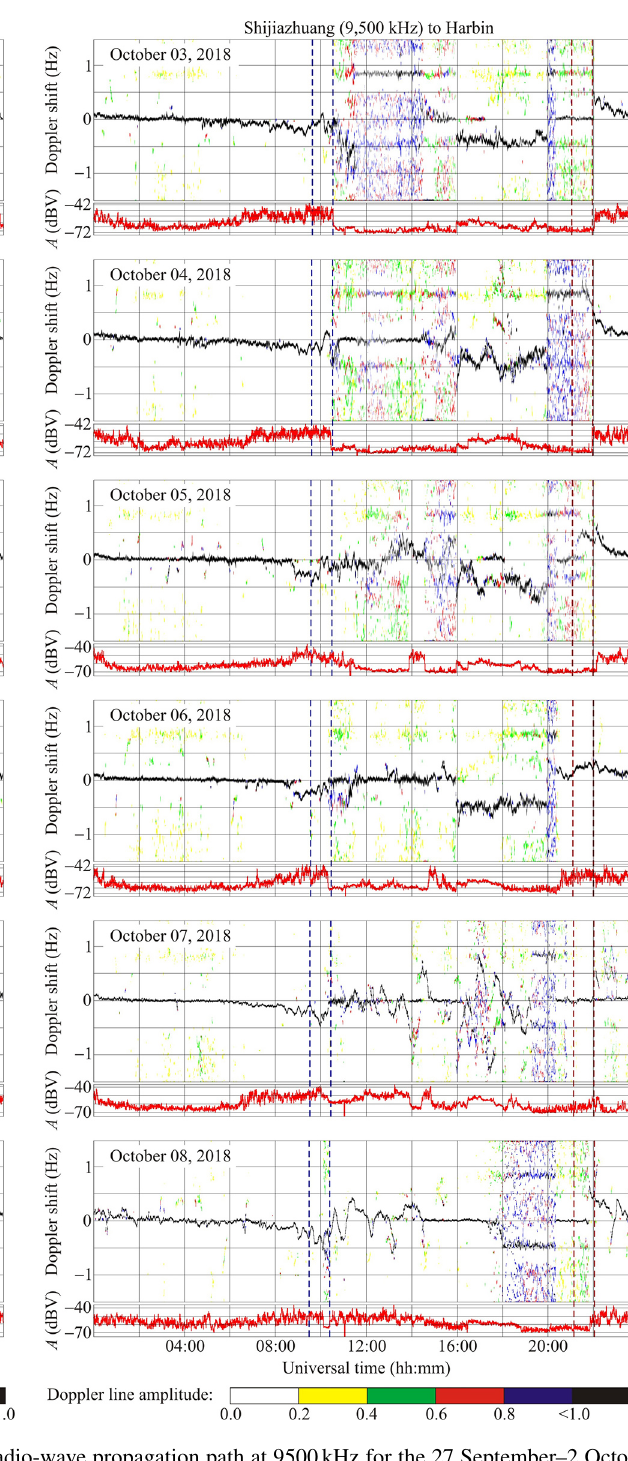
Figure 11. Same as in Fig. 6 but for the Shijiazhuang to Harbin radio-wave propagation path at 9500kHz for the 27 September–2 October and 3–8 October 2018